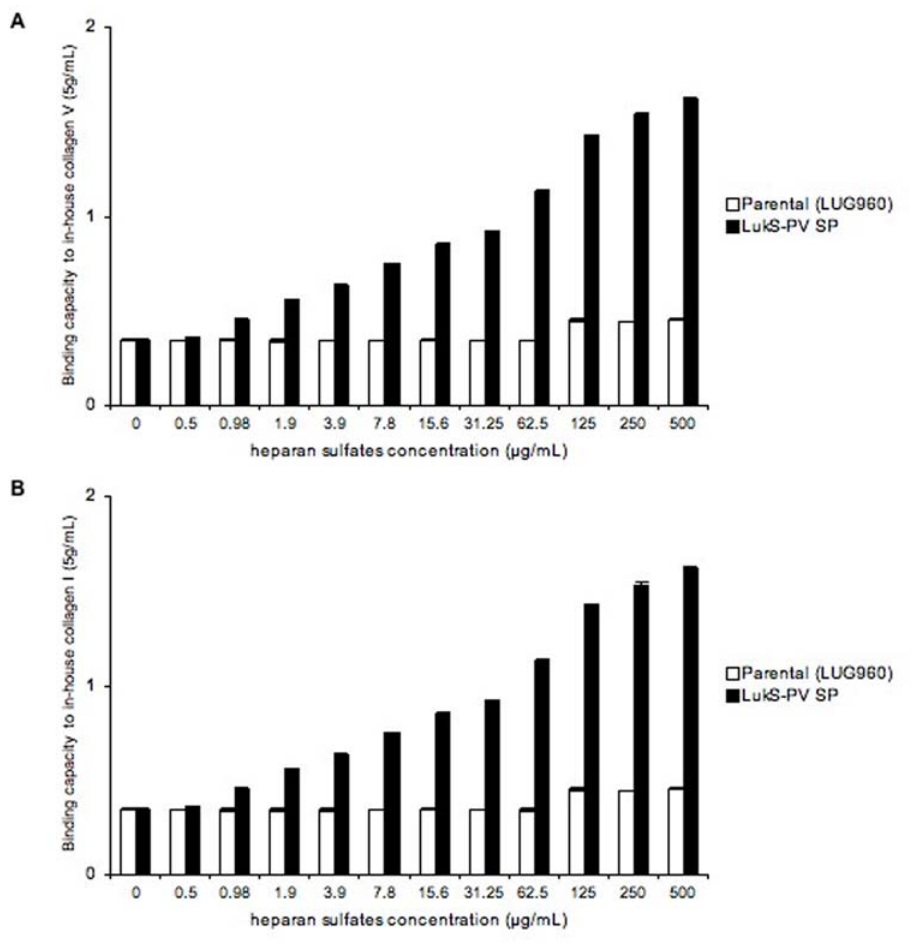
Figure 6. Binding capacity of isogenic strains to in-house collagens V and I after addition of increasing concentrations of heparan sulfates. Isogenic strains examined for their binding capacity (Y-axis, absorbance reading at 540 nm) to collagens I and V preparations from our laboratory coated on 96-well plates, at concentrations of 5 m g/mL. Before the adhesion assay, heparan sulfates were added at increasing concentrations (X-axis) to the plates coated with recombinant collagen V (panel A) or highly purified collagen I (panel B). Parental (LUG960) indicates the genetic background in which the genetic modifications were made; LukS-PV SP, parental carrying a plasmid encoding the LukS-PV signal peptide. The vertical lines indicate the standard deviations.